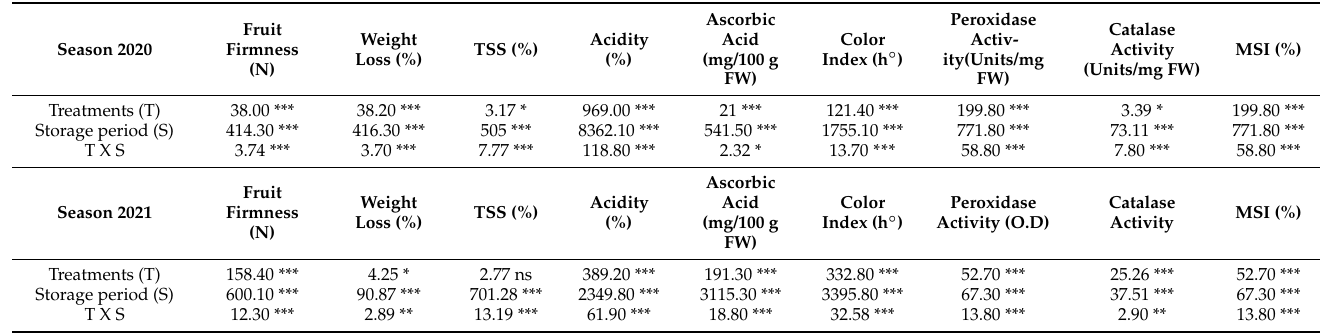
Table 3. Results of the analysis of variance with mean square testing the effects of treatments (T), storage period (S), and their interactions on fruit firmness (N), weight loss (%), TSS (%), acidity (%), vitamin C (mg/100 g FW), color index (h ◦ ), peroxidase activity (units/mg FW), catalase activity (units/mg FW), and MSI (%) during 2020 and 2021